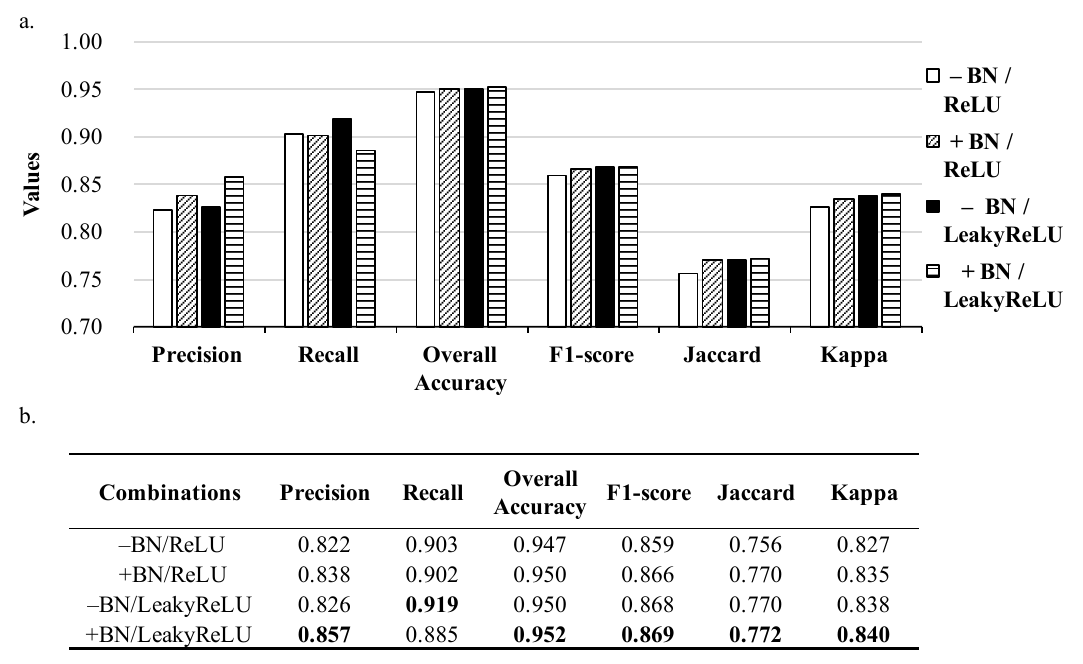
Figure 13. Comparison of segmentation performances of BR-Net models with various combinations of components. ( a ) Bar chart for performance comparison. The x- and y-axis represent the evaluation metrics and corresponding values, respectively. ( b ) Table of performance comparisons of methods. For each evaluation metric, the highest values are highlighted in bold